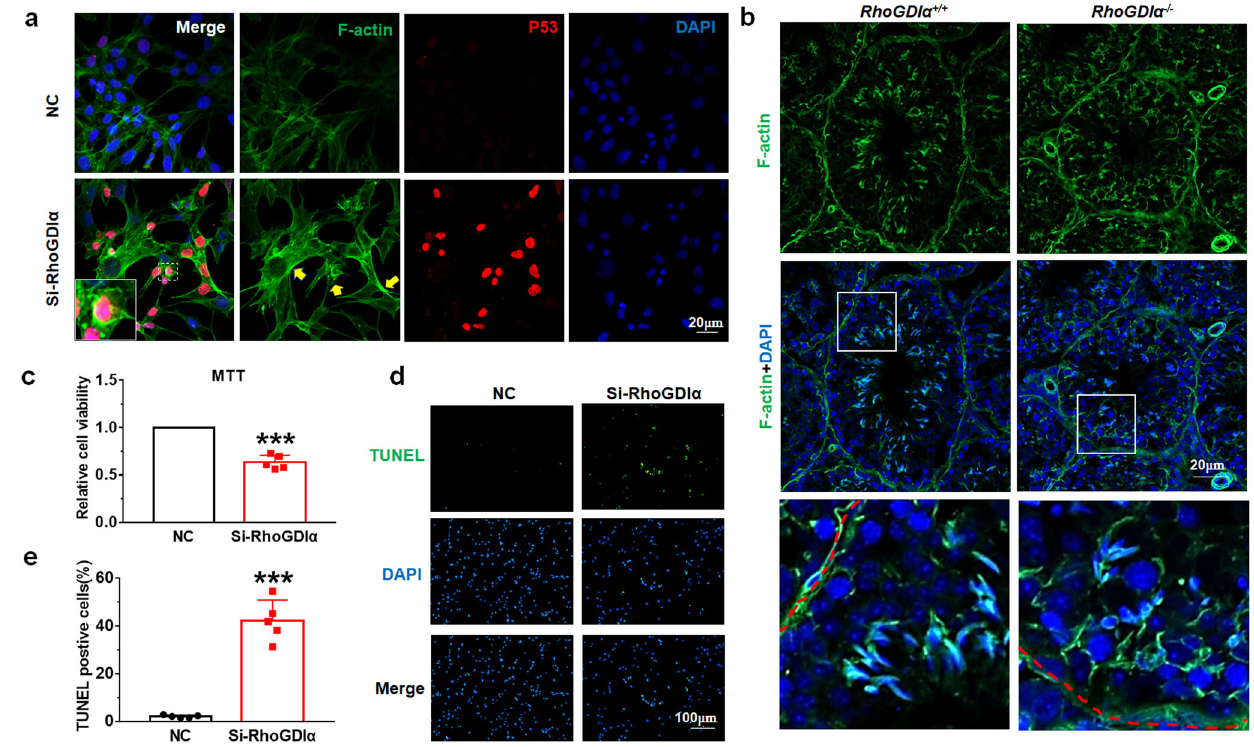
Fig. 5 F-actin polymerization and apoptosis occurred after RhoGDI α deletion. a Staining of F-actin and P53 was achieved using the natural compounds phalloidin and secondary antibody conjugated with different fl uorophores, respectively. The images in the white solid wire box are magni fi ed images of the corresponding image. The yellow arrow points to the part where F-actin polymerization occurred abnormally. Scale bar = 20 μ m. b F-actin expression in RhoGDI α + / + and RhoGDI α − / − mouse testes. The image on the last line is an enlarged view of the white box next to it. Scale bar = 20 μ m. c MTT assay was used to test cell viability after transfection of Si-RhoGDI α into GC-1spg cells. d , e Apoptosis of GC-1spg cells after Si-RhoGDI α transfection was detected using TUNEL assay. c , e n = 5 batches of cells in each group. Scale bar = 100 μ m. *** P < 0.001 vs NC group. Data are presented as the mean ± standard